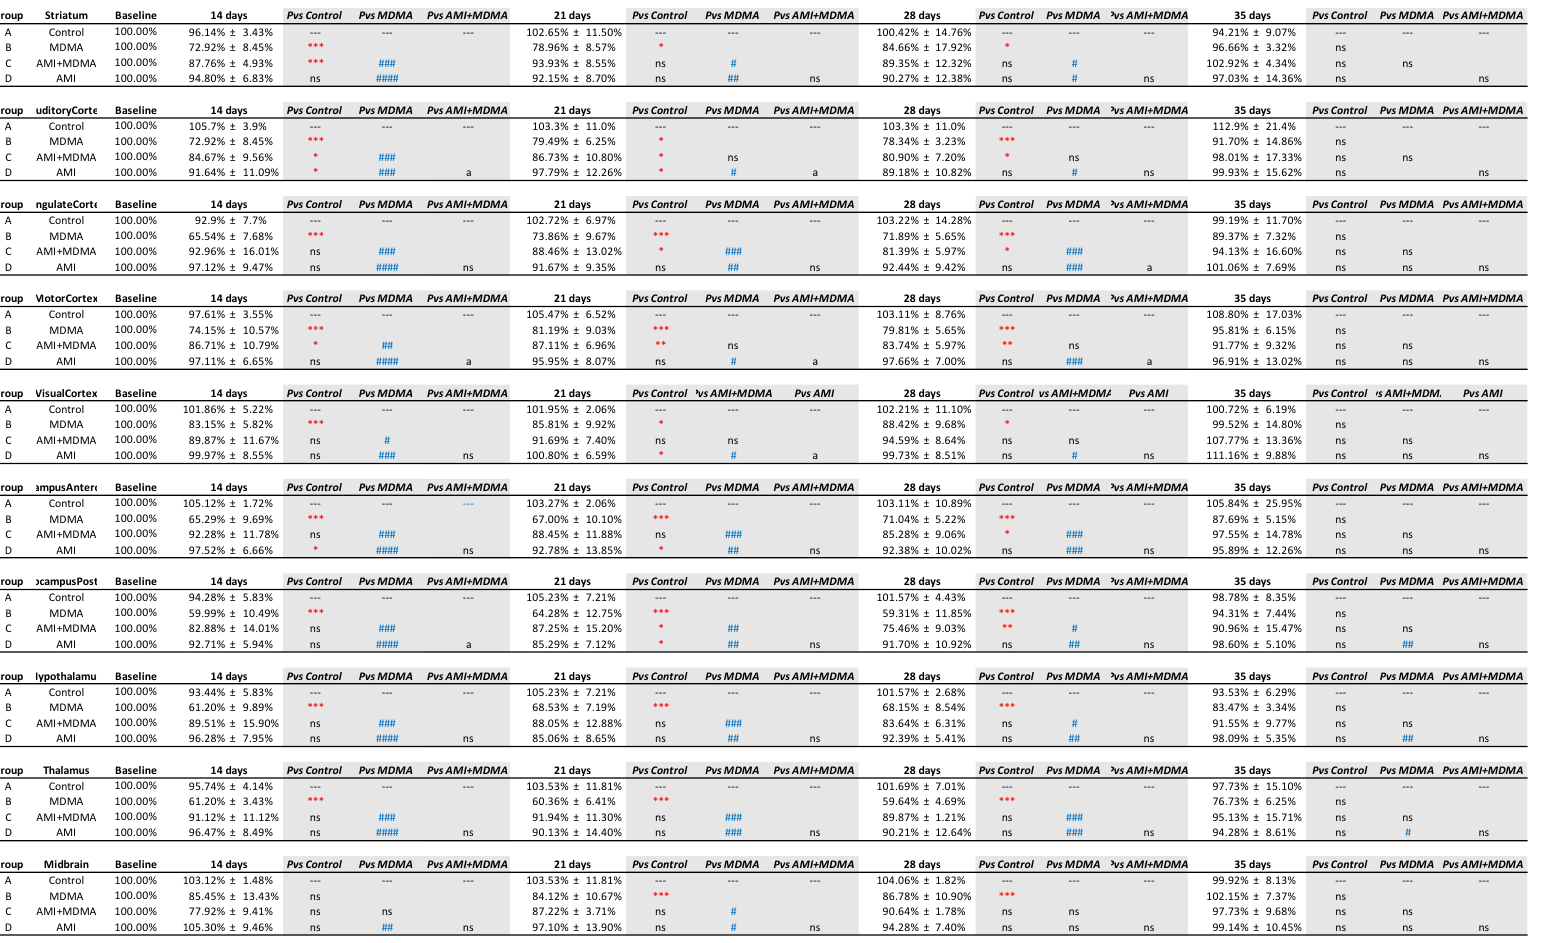
Figure 6. Recovery in brain SERT availability in 9 brain areas under different drug treatment from day 0 to day 35. Data are mean ± SD. Animals were grouped into (1) Group A: saline control; (2) Group B: MDMA; (3) Group C: AMI with MDMA; or (4) Group D: AMI alone. Different superscript symbols denote different level of significance (red * p < 0.05, ** p < 0.01, *** p < 0.005 Group B or C or D vs. Group A; blue # p < 0.05, ## p < 0.01, ### p < 0.005, #### p < 0.001 Group A or C or D vs. Group B; a p < 0.05, Group A or B or D vs. Group C, ns = not